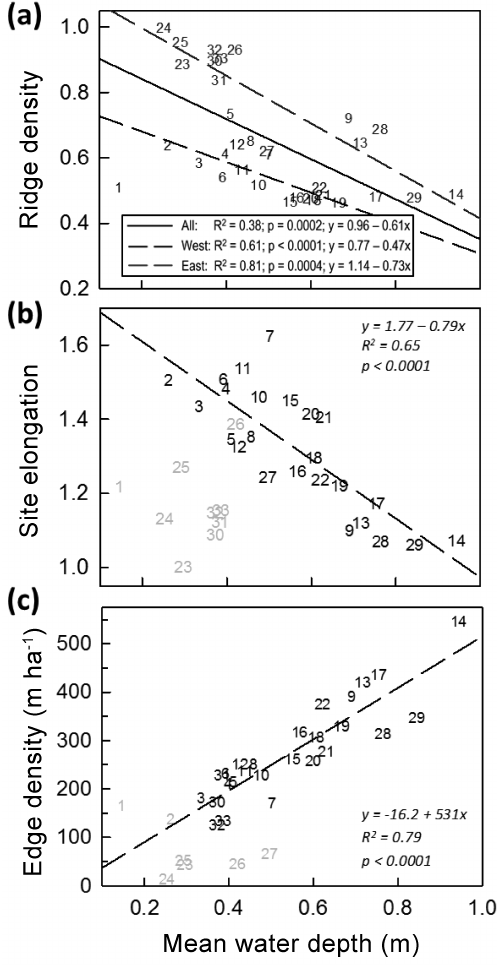
Figure 2. (a) Ridge density is negatively correlated with mean wa- ter depth. Eastern sites (blue) show consistently higher ridge densi- ties than those in the west (black). Trends associated with east–west segregation (dashed lines) show much stronger relationships than the composite trend (solid line). Site 1 was omitted due to possible misclassification. (b) Site elongation shows a strong negative re- lationship with mean water depth. Sites with ridge densities greater than 0.8 (indicated in grey) were omitted from regressions and show elongation values lower than expected from this trend. (c) Edge den- sity is positively correlated to mean water depth indicating higher perimeters in deeper sites. Sites indicated in grey were mapped at lower resolution and were omitted from regressions. The relation- ships observed for site elongation and edge density are both con- sistent with patches becoming disaggregated with increased water